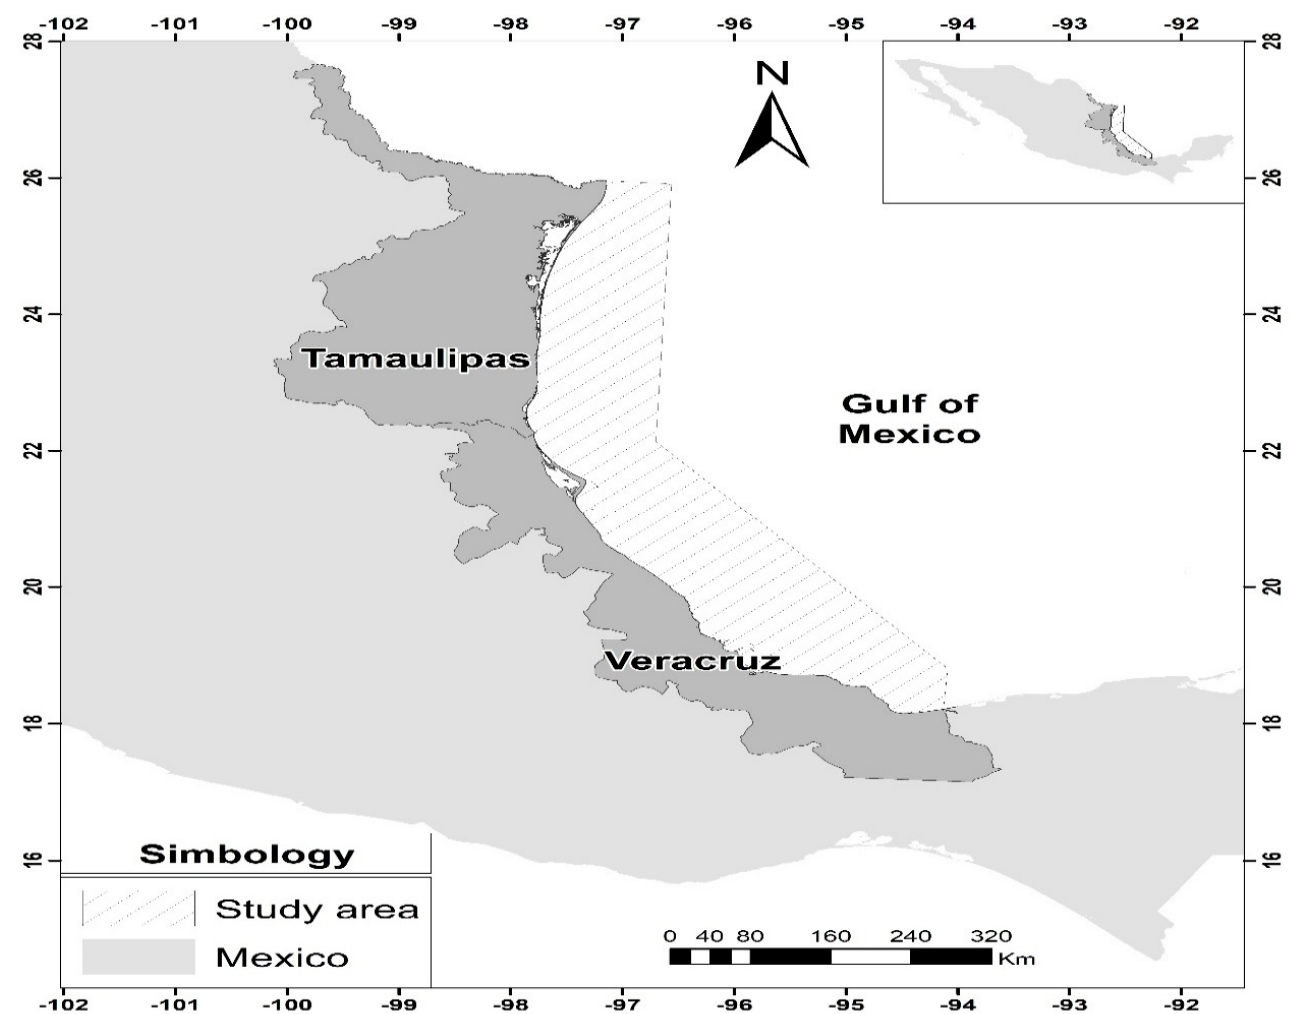
Figure 1. Sampling sites in the study area for brown shrimp Penaeus aztecus in the Gulf of Mexico.